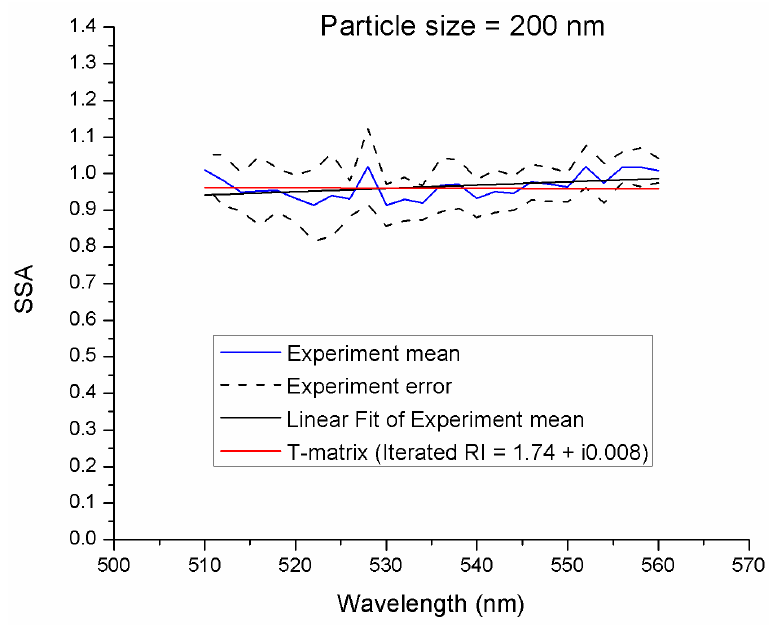
Figure 5. Comparison of T-matrix SSA (using RI = 1.74 + i0.0081) with experimental SSA for 200-nm fresh biomass burning (BB) particles produced using a tube furnace.